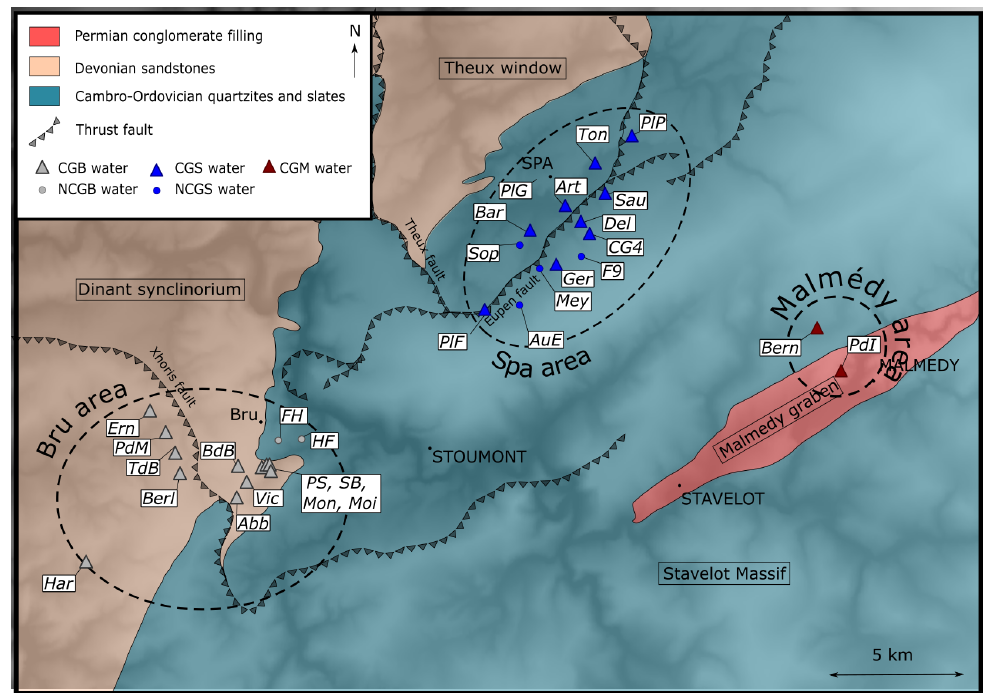
Figure 3. Location of each sample with regard to the main geological features.